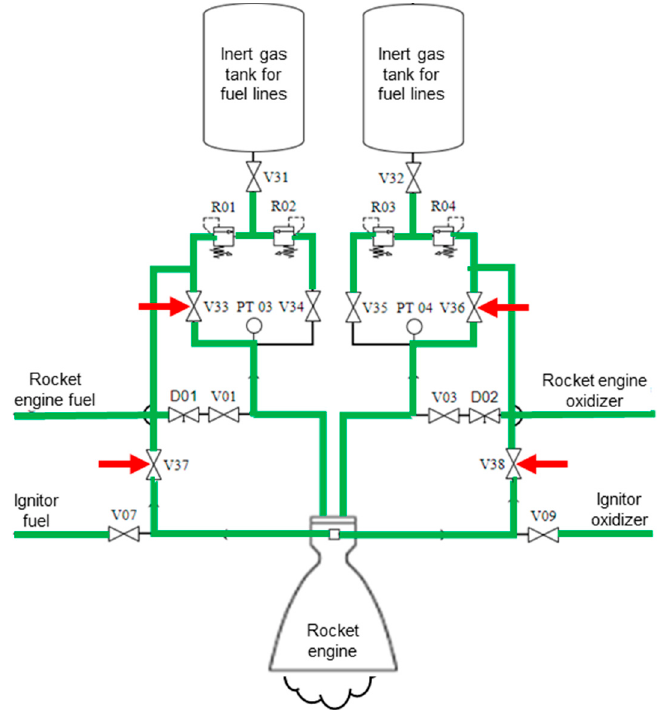
Figure 23. Algorithm’s eighth step diagram.